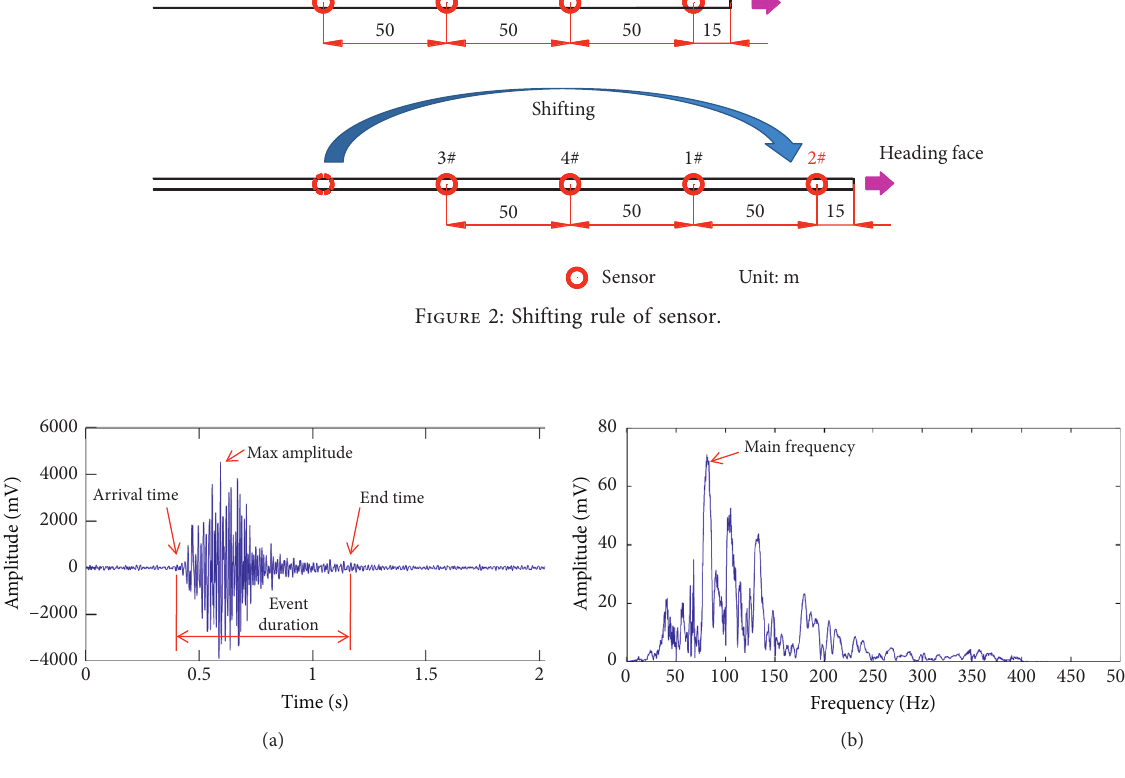
Figure 3: Statistical basic parameters of MS event waveform. Table 3: Sensor sequencing results in different periods. Sensor sequencing (from heading face to back)